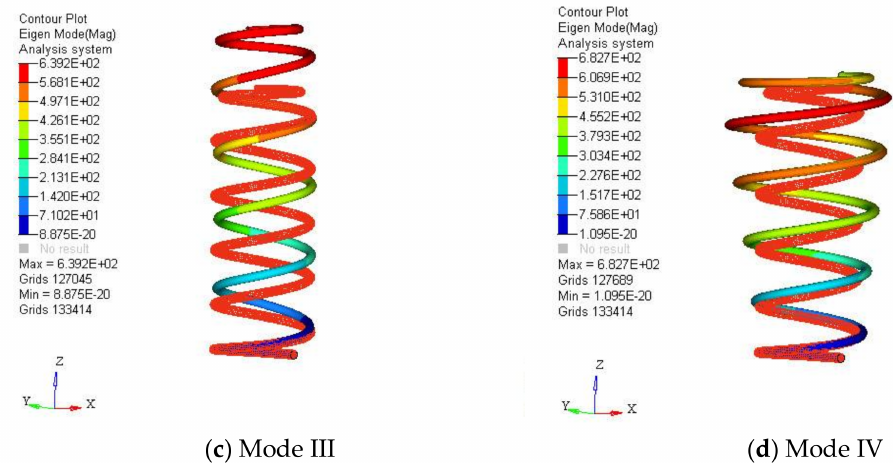
Figure 6. Mode shape of coil spring for different frequencies: ( a ) 173 Hz; ( b ) 180 Hz; ( c ) 458 Hz; and, ( d ) 550 Hz.